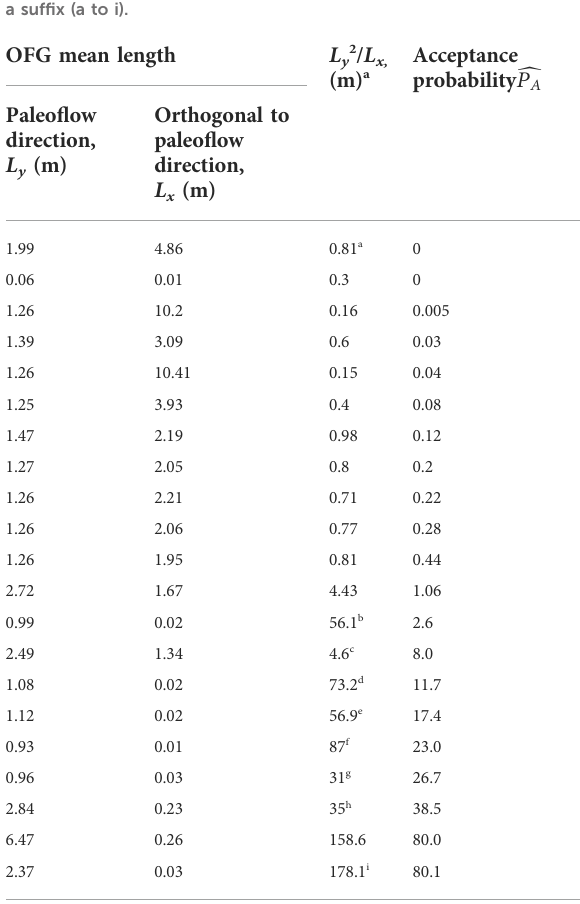
TABLE 1 Rate of producing plausible fi elds for 21 alternative geostatistical model hyperparameters, and the OFG mean lengths in the paleo fl ow ( L y ) and perpendicular to paleo fl ow ( L x ) directions. Representative samples from the range of plausible geostatistical model hyperparameters identi fi ed in the initial conditioning step were selected for prediction uncertainty analysis are identi fi ed by a suf fi x (a to